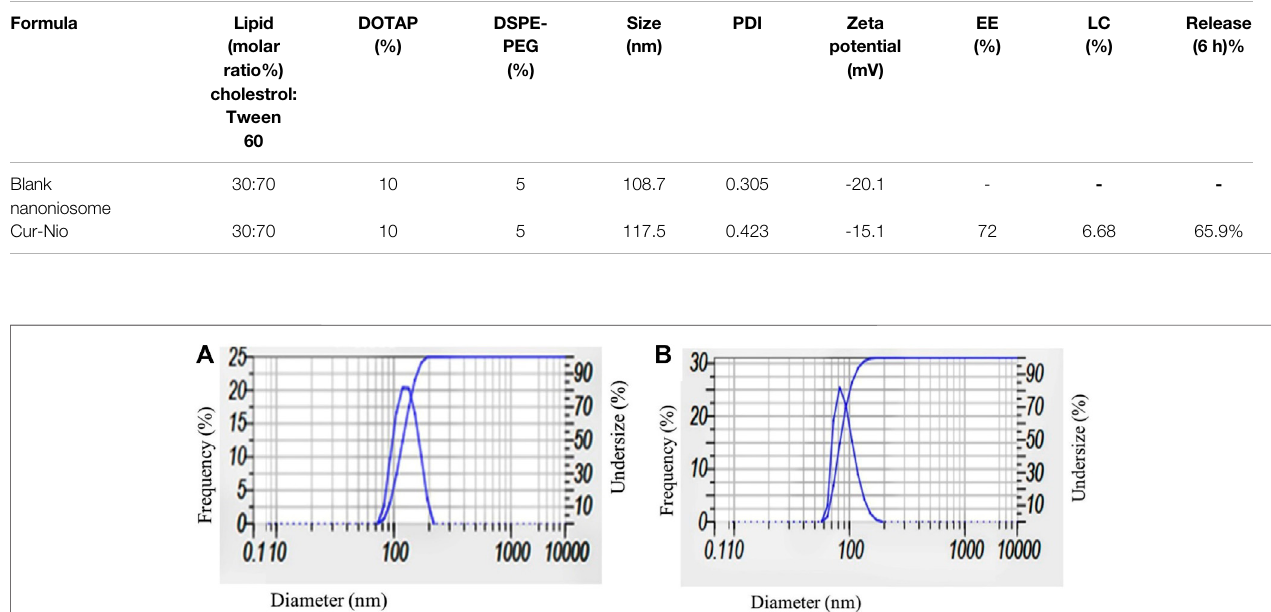
Frontiers in Bioengineering and Biotechnology |